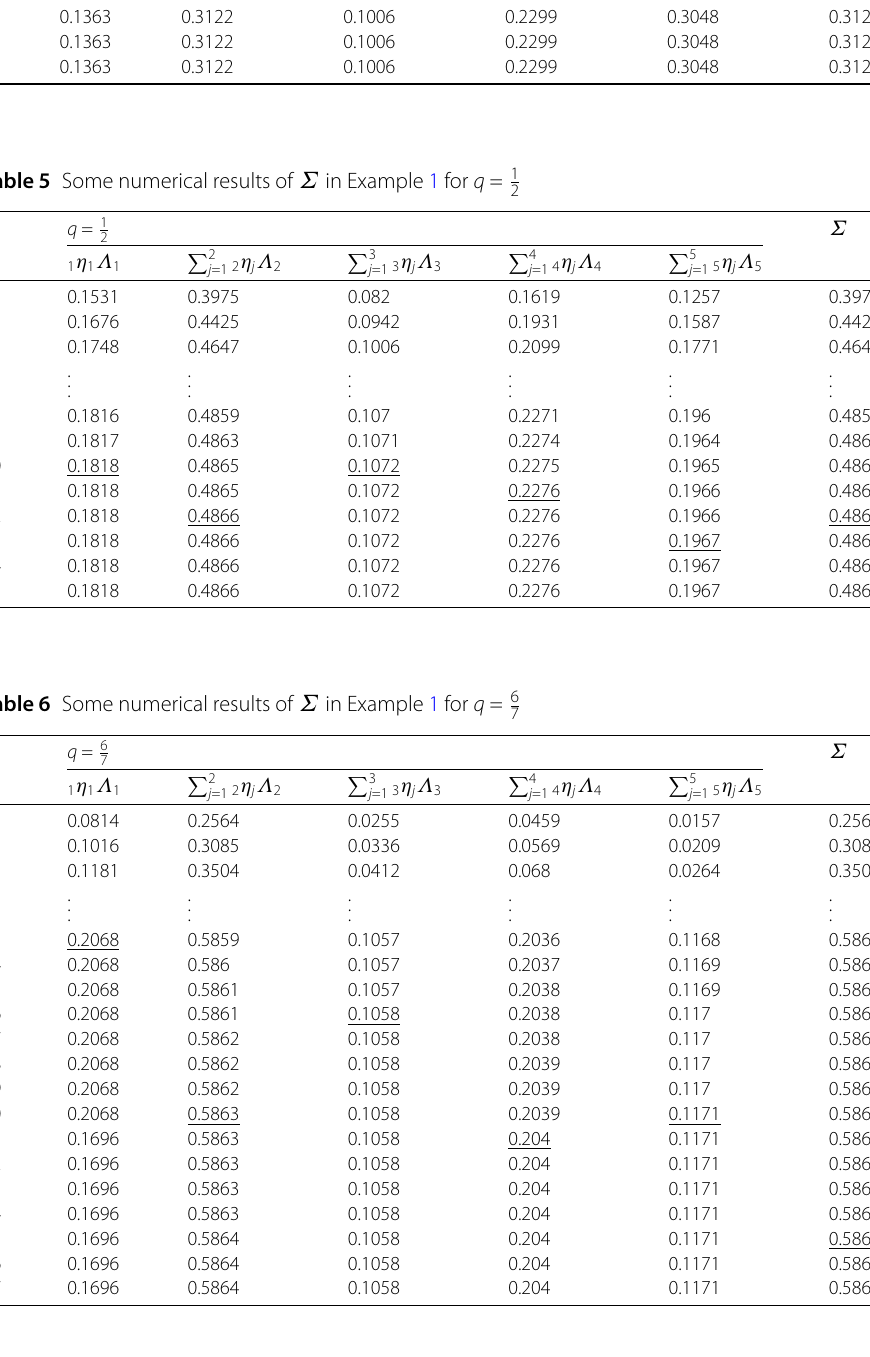
Table 5 Some numerical results of Σ in Example 1 for q = 1